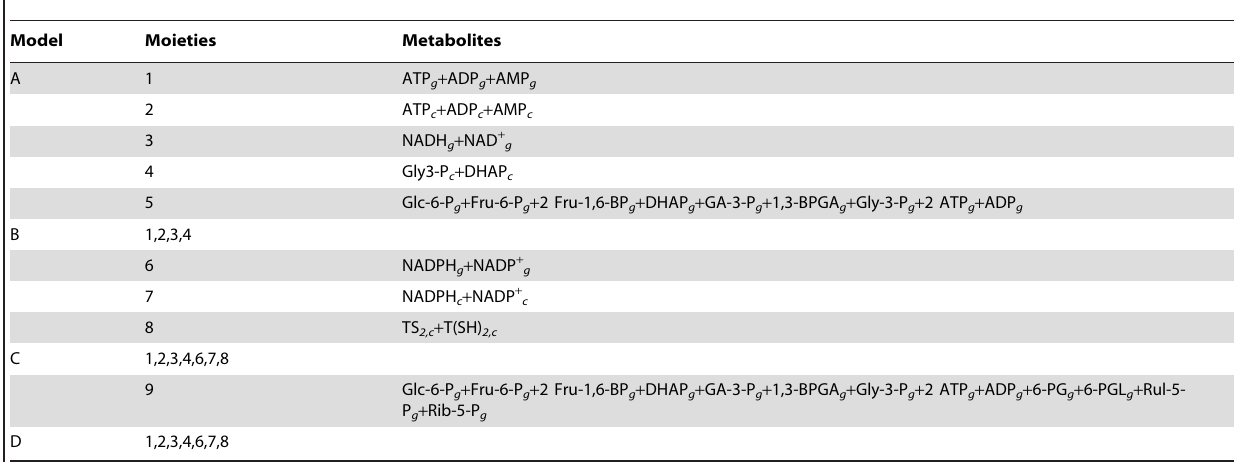
Table 2. Conserved moieties in the four models of Figure